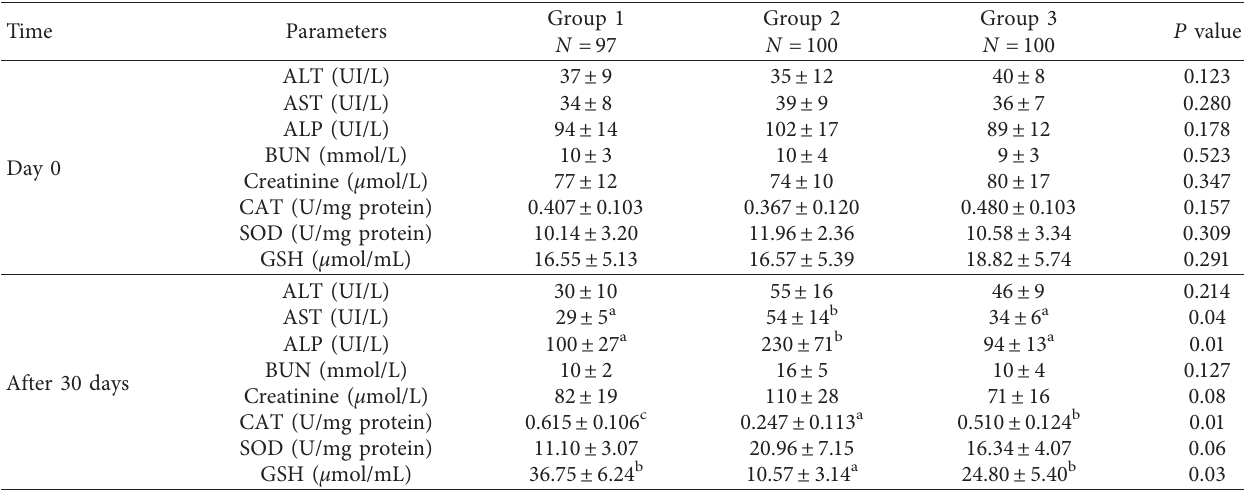
Table 4: Variation of biochemical parameters in different